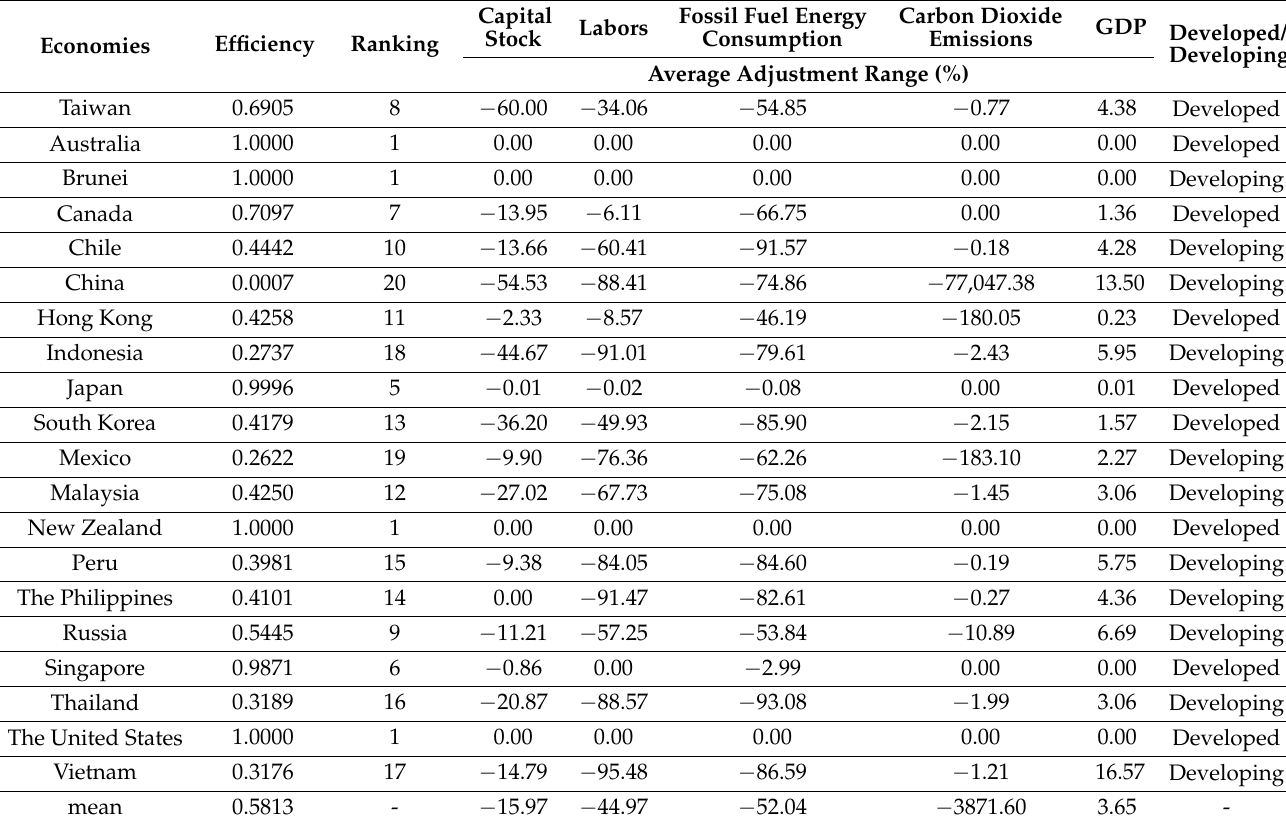
Table 10. A summary of energy efficiency, ranking, and adjustment arrangement of variables for APEC economies.